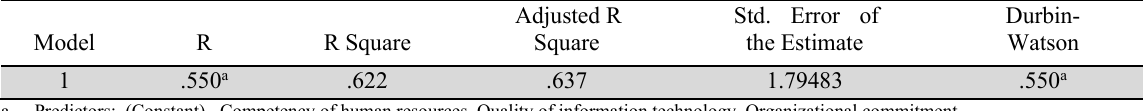
Multiple Linear Regression Test Results Model